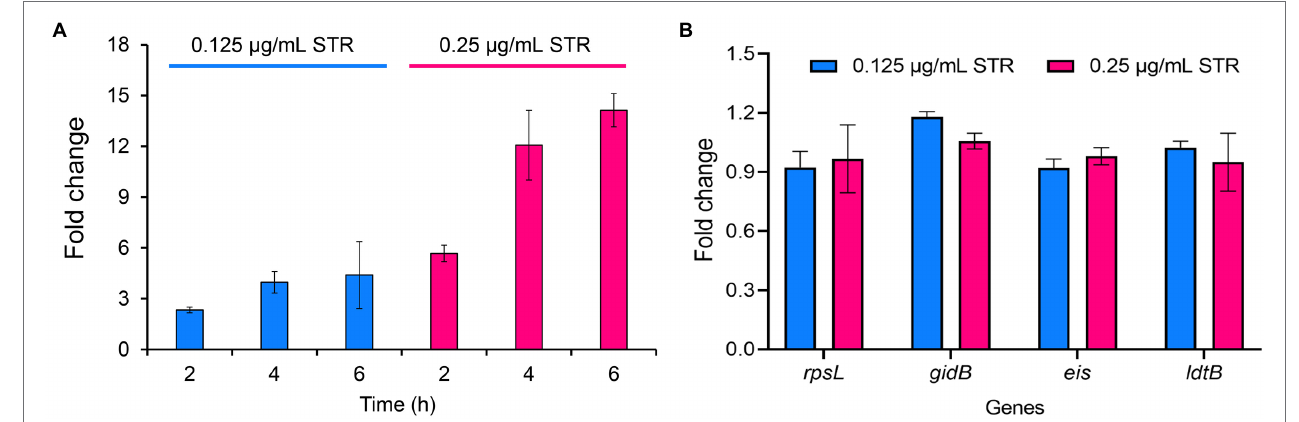
FIGURE 5 | Streptomycin induces increased expression of aroB in Mycobacterium bovis BCG. (A) Expression of aroB at 2, 4, 6 h post-cultivation. The mid-log phase of M. bovis BCG (OD 600 = 1.0) was cultivated with 0.125 and 0.25 μ g/ml streptomycin to induce the expression of aroB , and aroB expression in M. bovis BCG strain was detected by quantitative real-time PCR (qRT-PCR). (B) Expression of rpsL , gidB , eis , and ldtB genes at 6 h post-cultivation. The expression of streptomycin resistance-related genes rpsL and gidB , and unrelated genes eis and ldtB after streptomycin treatment were quantitatively detected. Relative expression levels of the genes were normalized with the sigA gene as internal reference. The data were analyzed using the 2 −ΔΔ Ct method. Barplot shows the mean and SD of three biological